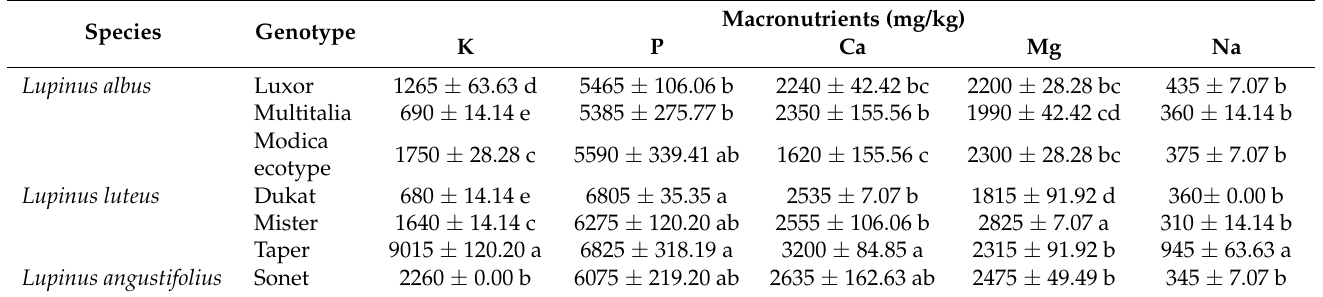
Table 2. Content of macronutrients in different Lupinus spp.